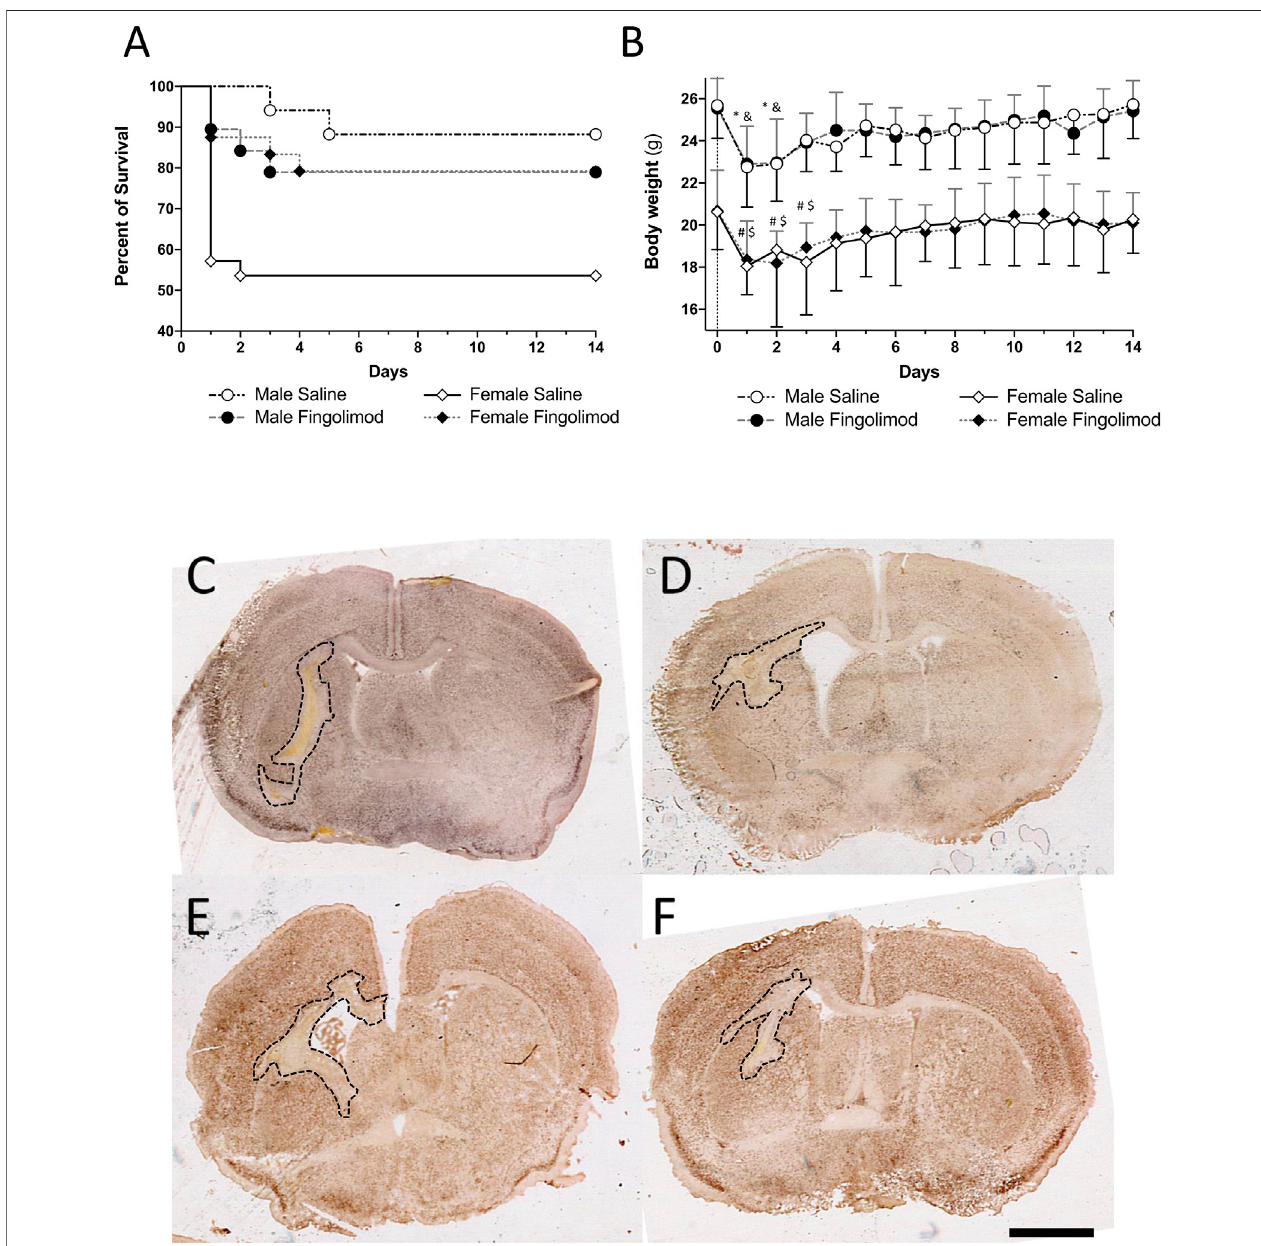
FIGURE2|(A) Kaplan-Meir survivalgraph;femalemicetreatedwith fi ngolimodhadahighersurvivalproportionthanvehicle-treatedmiceandvehicle-treatedmale mice have a higher chance of survival than their female counterparts. (B) Weights over time shown as mean ± SD. Signi fi cant differences: * male saline compared to baseline; & male fi ngolimod compared to baseline; # female saline compared to baseline; $ female fi ngolimod compared to baseline. (C – F) Photomicrographs of NeuN stainedsectionrepresentativeICH-induceddamageat14daysinsaline- (A) and fi ngolimod-treatedmalemice (B) ,insaline- (C) and fi ngolimod-treatedfemalemice (D) . All images were taken at the level of the anterior commissure. Lesions in all four tissue sections are outlined in black. Scale bar: 1